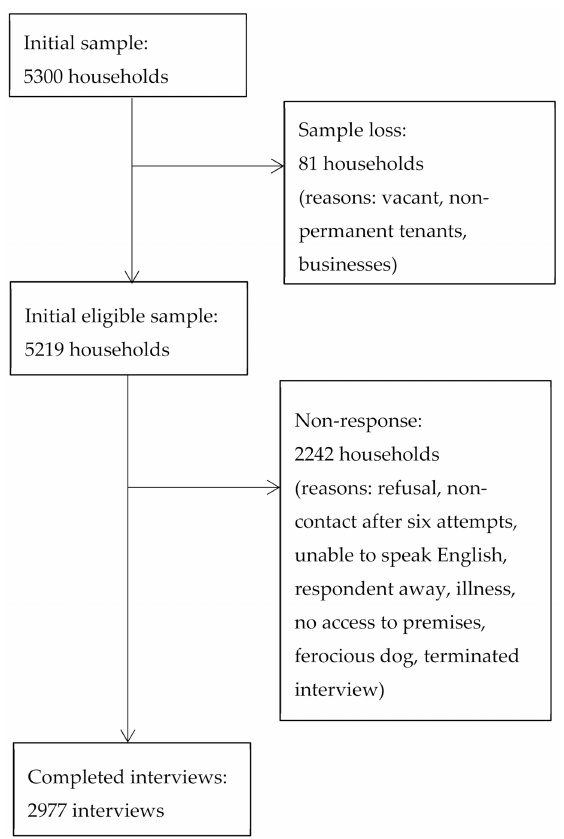
Figure 1. Participant